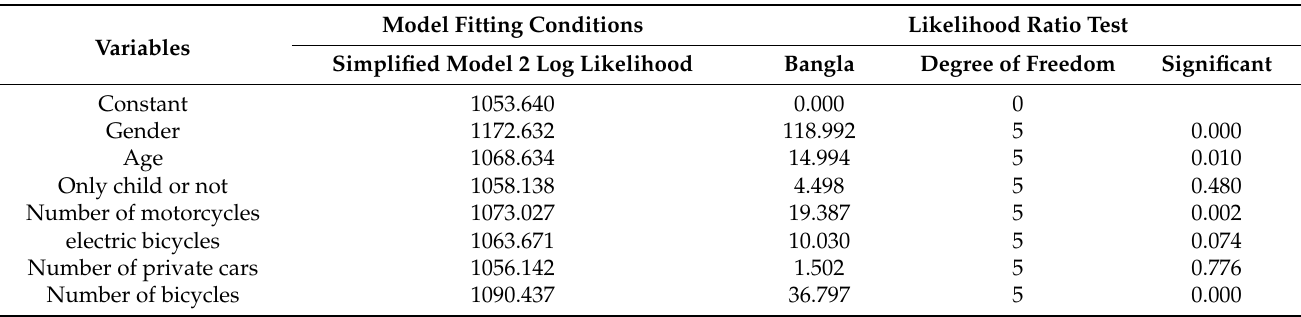
Table 7. Likelihood ratio test for independent variables.